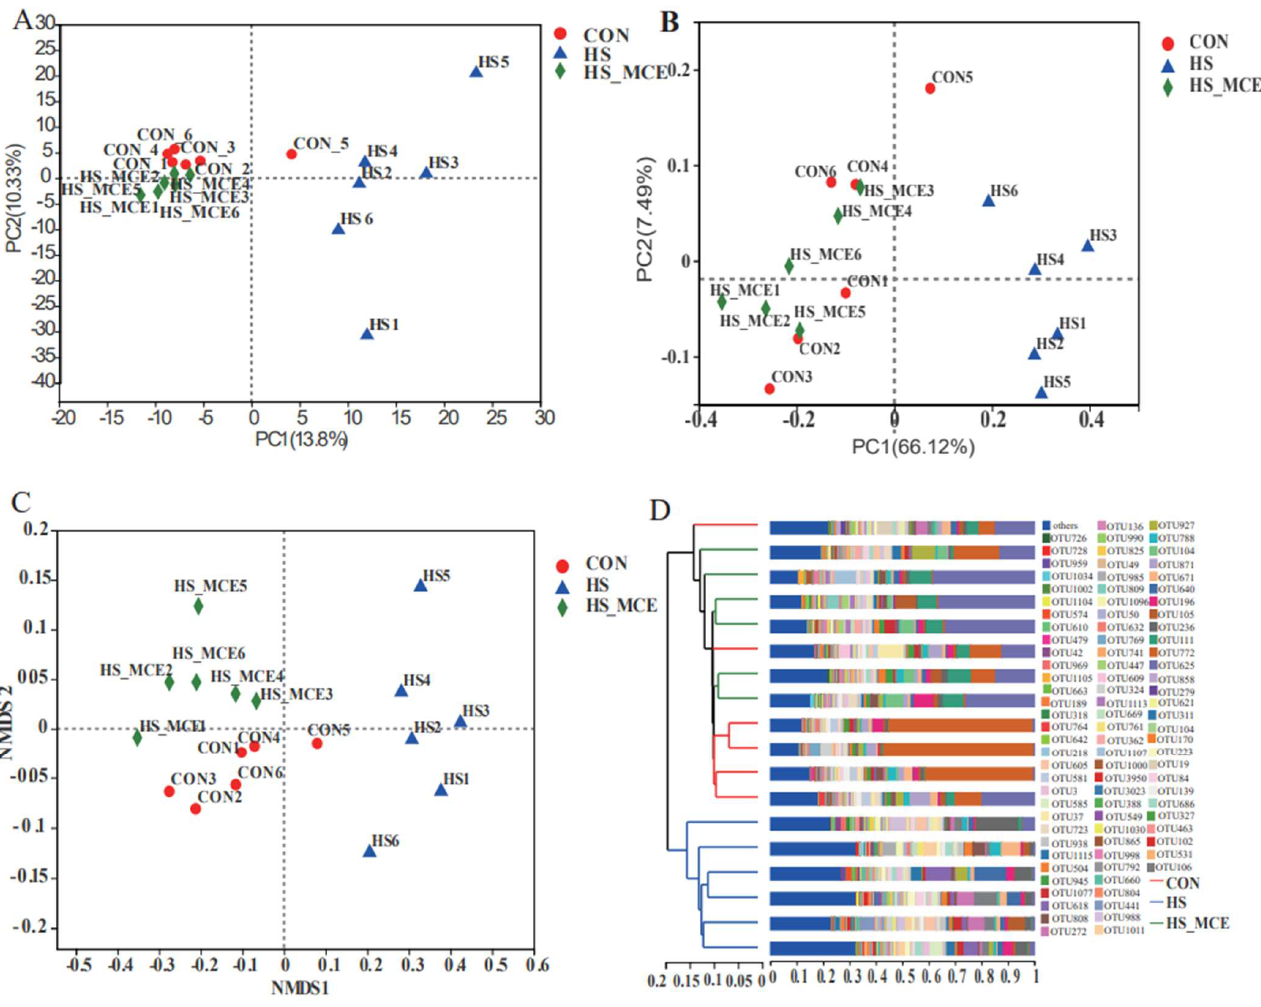
Figure 3. Effects of MCE on cecal bacterial Beta diversity. ( A ) PCA analysis, ( B ) PCoA analysis, ( C ) NMDS analysis, and ( D ) Hierarchical cluster analysis. CON for the Control group, HS for the Heat Stress group, and HS-MCE for the Heat Stress plus Macleaya cordata extract group.